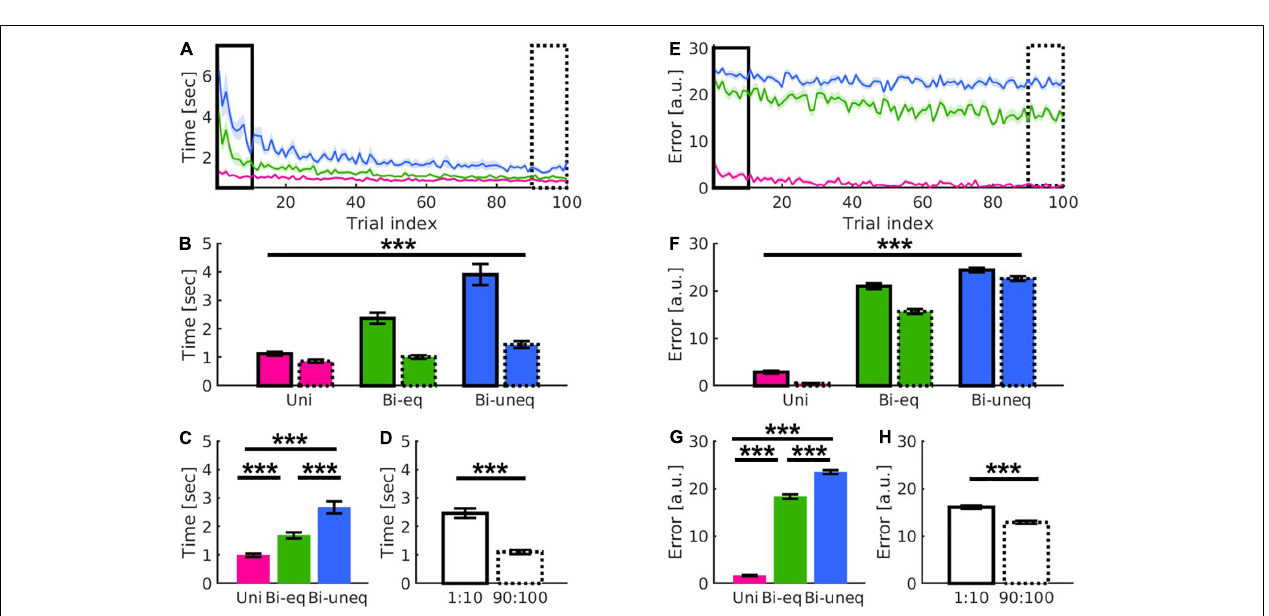
FIGURE 3 | Results of the training task (red) and transfer task (grey). (A,B) Qualitative presentation of the reduction of movement time and error with learning. (C,D) Quantitative comparison of the first ten (solid frame) and the last ten trials (dashed frame) of the training task with the transfer task conducted before (pre) and after (post) the training task. (E) Correlation plot of movement time changes and error changes in the training task. Error bars are standard errors of the mean. Significance stars ∗∗∗ mean p < 0.001.